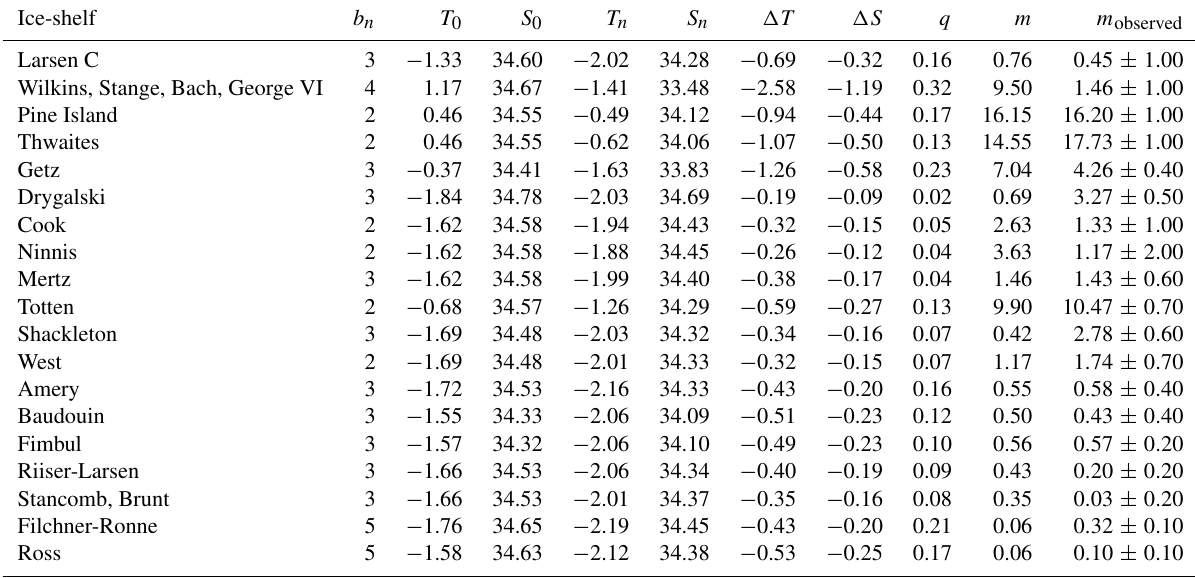
Table 2. Results from the reference simulation as displayed in Fig.